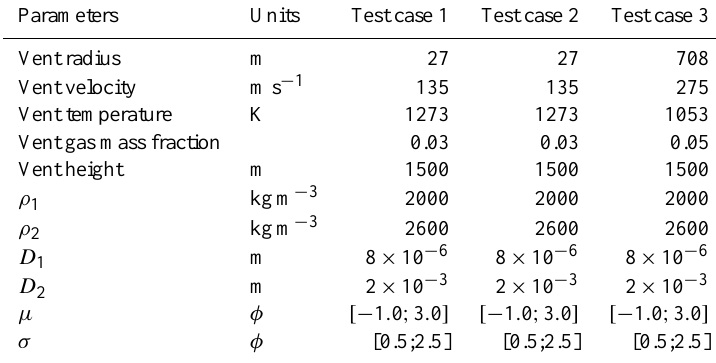
Table 1. Input parameters used for the numerical simulations. Vent height is the elevation of the base of the column above sea level. The values ρ 1 , 2 and D 1 , 2 are used to compute the density of the particles as a function of the diameter, according to the formulation of Bonadonna and Phillips (2003). The values reported for µ and σ define the range used for the uncertainty quantification and sensitivity